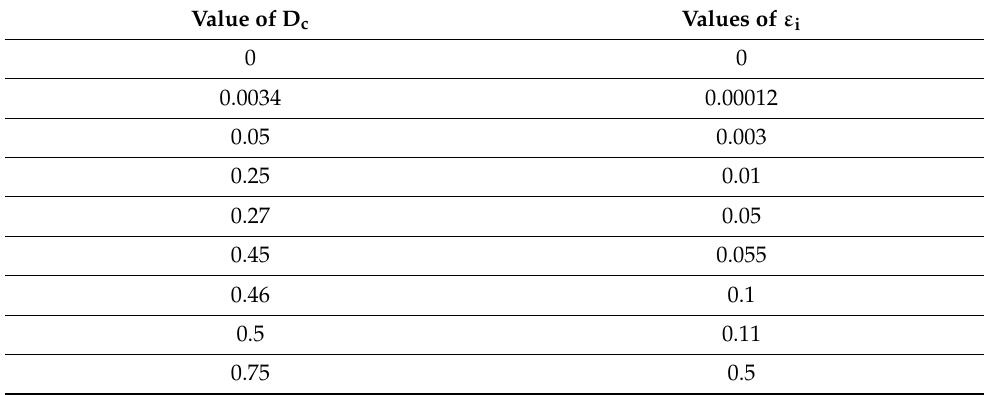
Table 1. Values of parameters of damage evolution under compression.